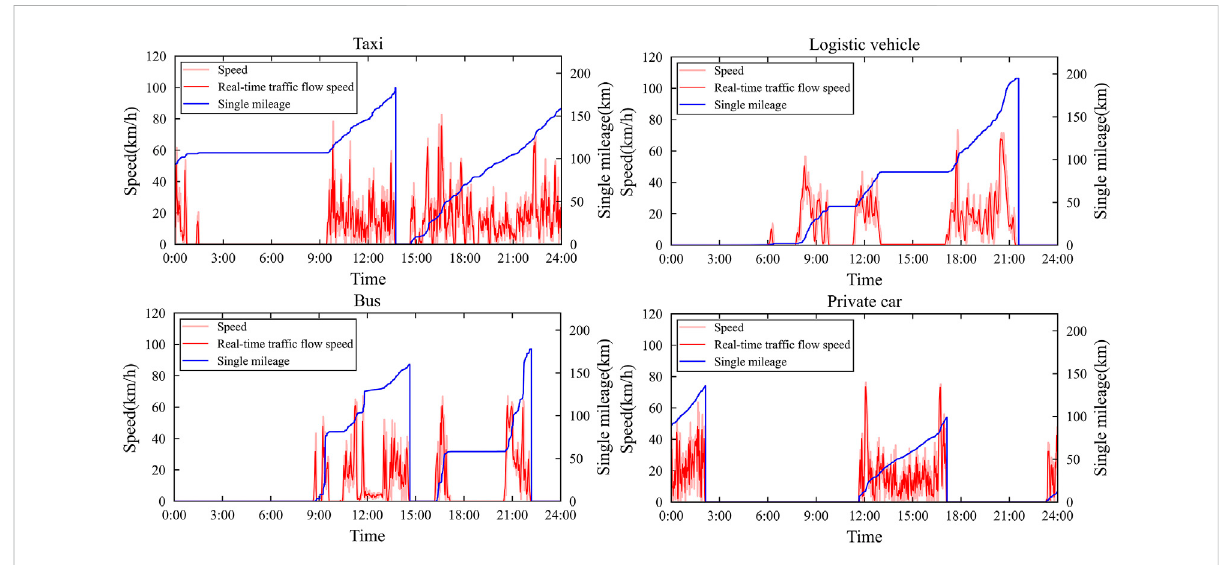
FIGURE 8 Single vehicle 24-hour speed and mileage prediction